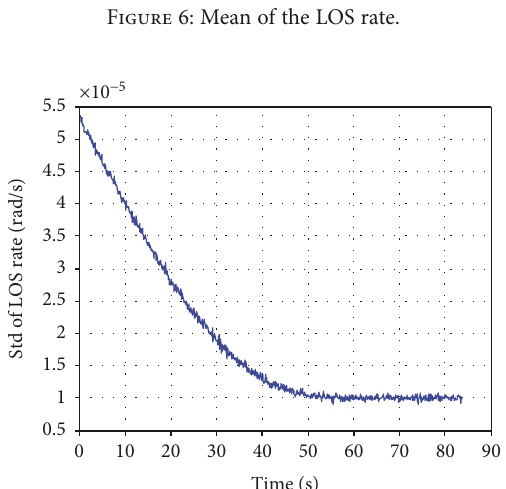
Figure 7: Standard variance of the LOS rate.